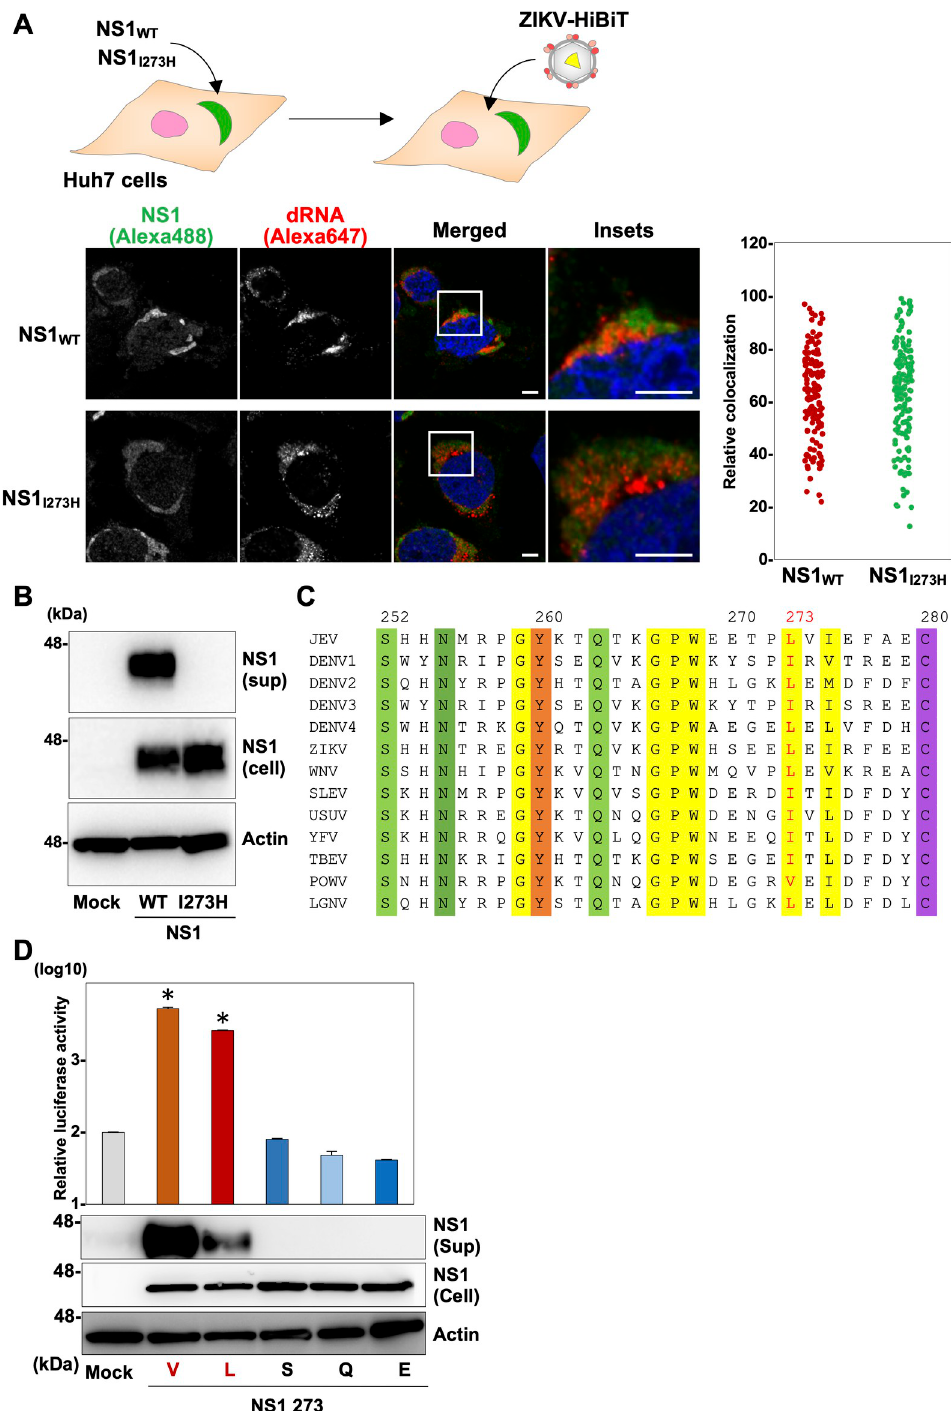
Fig 3. Basic amino acids residues at position 273 of NS1 play a crucial role in the secretion of NS1. (A) An illustration shows the experimental workflow. Either the wild type or I273H mutant NS1 was expressed in Huh7 cells. Localization of NS1 and dsRNA in cells infected with ZIKV-HiBiT was observed at 48 hpi by confocal microscopy using antibodies against NS1 (red dots in the left panels) and dsRNA (green dots in the middle panels), respectively. The nuclei were counterstaining by Hoechest 33342. The white bar represents 10 μ m. dsRNA- and NS1-positive regions were extracted and their colocalization was determined and shown as a dot graph. (B) Intracellular (Cell) and extracellular (Sup) expressions of the wild type NS1 and NS1 I273H mutant were determined by immunoblotting. (C) The